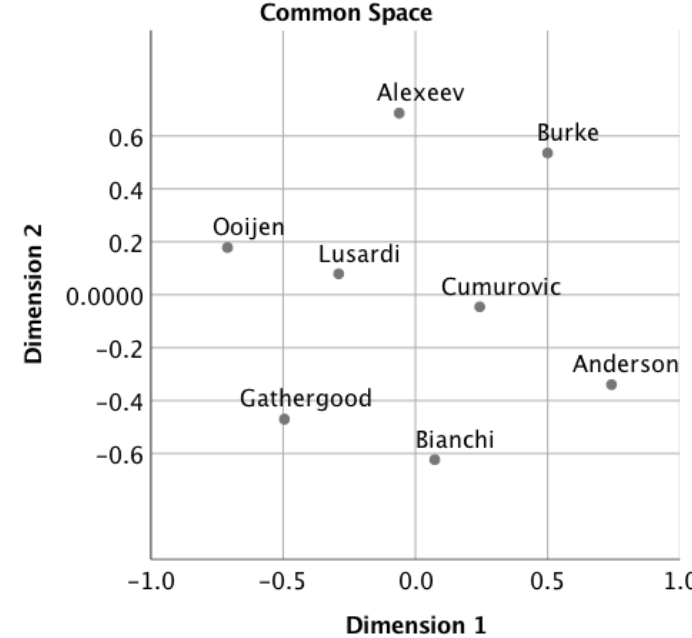
Figure 1. Multidimensional scaling of the financial literacy measures shows that the scales by Lusardi and Cumurovic are most